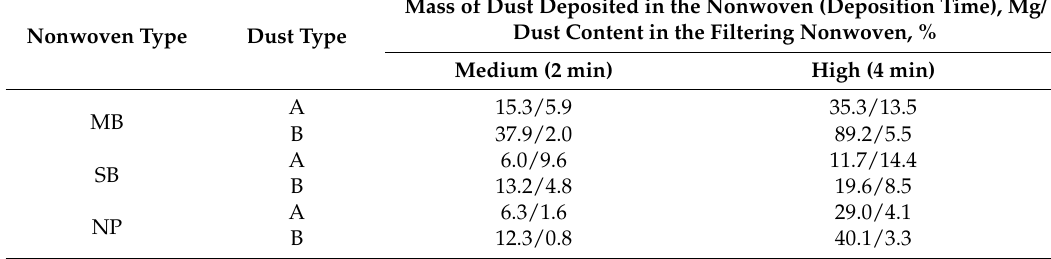
Table 2. Dust content in the nonwoven